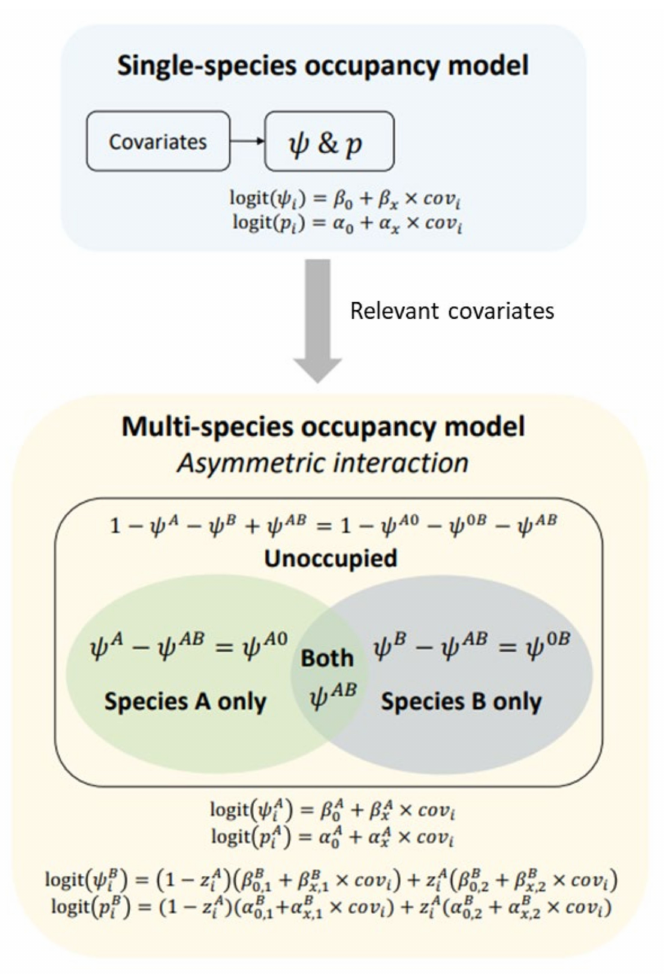
Figure 3. Workflow depicting single-species, single-season model ( top ), and multi-species asym- metrical interaction occupancy model ( bottom ). Single-species occupancy models were used to identify best covariates for each species. Multi-species occupancy models were used to examine the probability for each occupancy state (coloured Venn diagrams). The green ellipse represents the probability that the species A occupies a site irrespective of species B, and the grey ellipse represents the probability that species B occupies the site irrespective of species A. The intersection represents the probability that the site is occupied by both